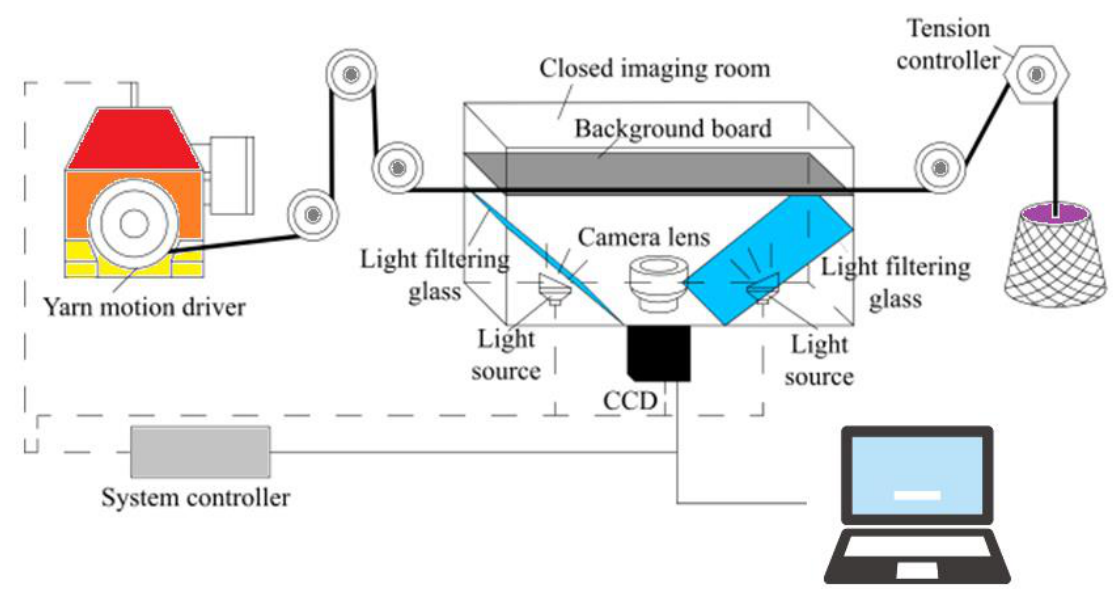
Figure 2. System device to detect yarn parameters (Adapted from [6]).